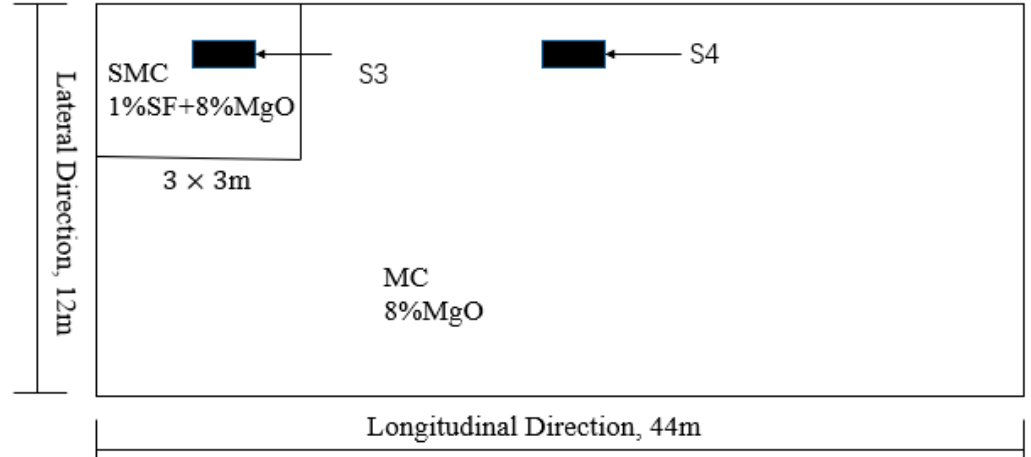
Figure 4. Location of testing sections. SMC: steel fiber reinforced MgO concrete; SF: steel fiber; MC: MgO concrete.